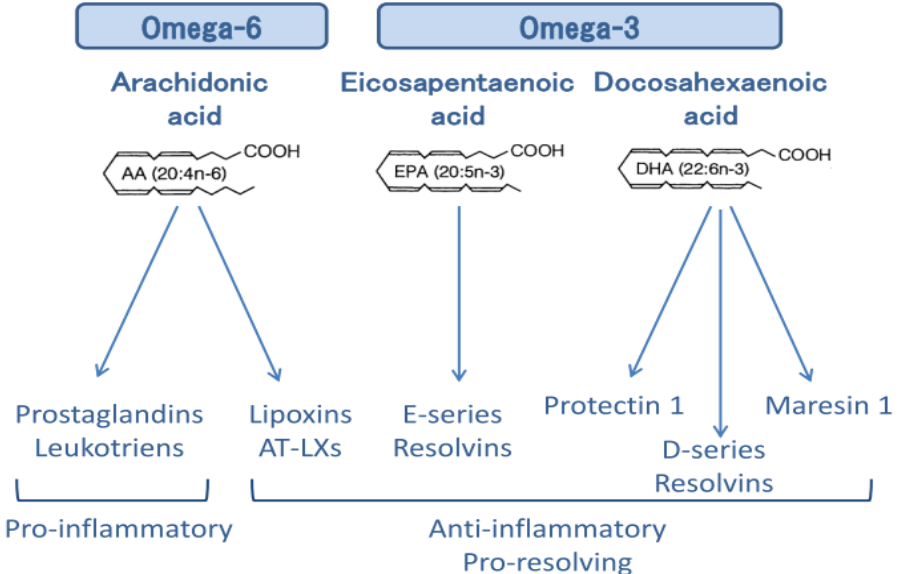
Figure 2. Specialized pro ‐ resolving mediators (SPMs) derived from ω‐ 3 and ω‐ 6 PUFAs. AT ‐ LXs: Aspirin ‐ Triggered Lipoxins.